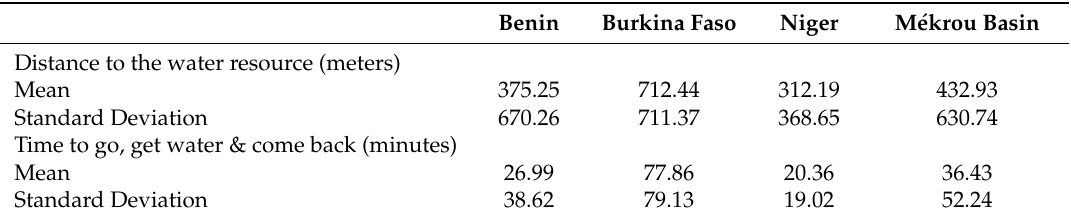
Table 3. Distance and time to the water